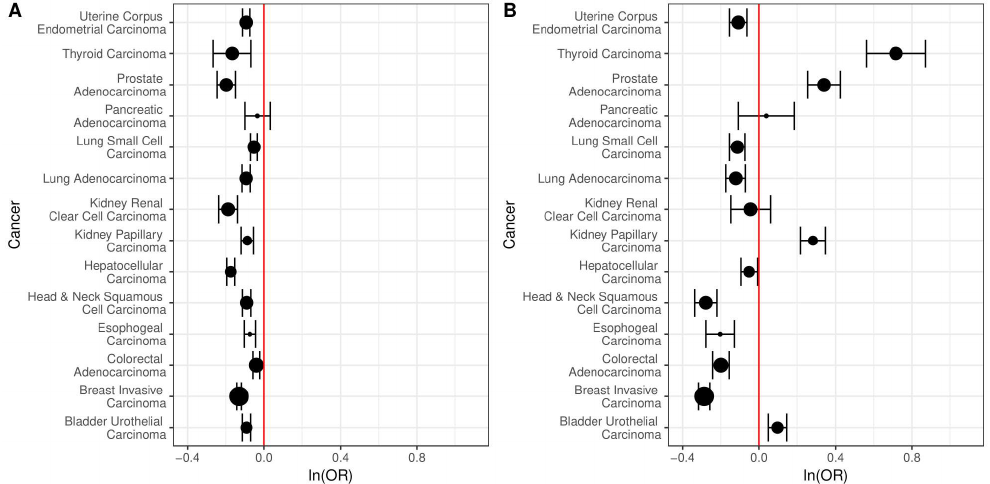
Figure 6. The log odds of intersecting regions of copy number alteration in bidirectional vs. single gene promoters. The size of the points indicates the relative sample size and 95% confidence intervals are shown. ( A ) The odds of intersecting regions of copy number alteration are lower for the 725 C/C bidirectional compared to 17,639 single gene promoters, across all 14 cancers. These results are statistically significant for 13 out of 14 cancers; ( B ) The odds of intersecting regions of copy number alteration are lower for the 135 C/N bidirectional compared to single gene promoters, across 9/14 cancers. The results are statistically significant in 12 out of 14 cancers.